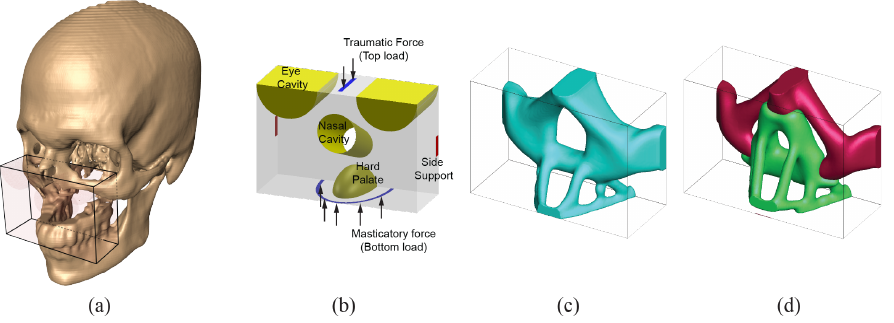
Figure 5. Case 1. ( a ) Design domain extraction from patient CT scan, ( b ) boundary condition used in the analysis, ( c ) bone replacement shape using single material topology optimization, ( d ) bone replacement shape using multi-material (2 materials) topology optimization.